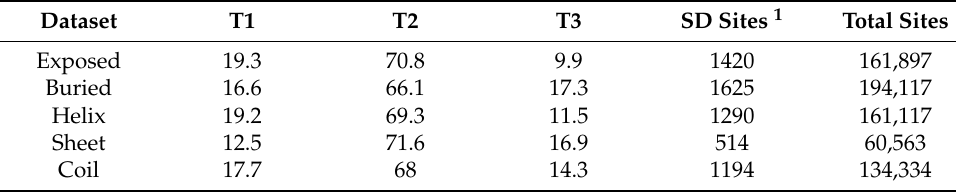
Table 1. Percentages of strongly decisive (SD) sites in the complete FSD.